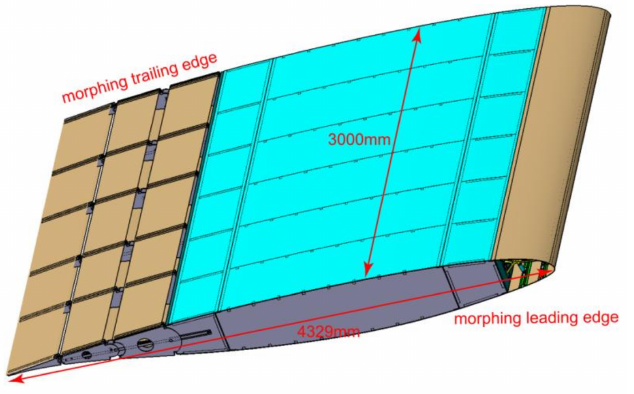
Figure 4. Two-dimensional morphing wing digital mockup with morphing leading and trailing